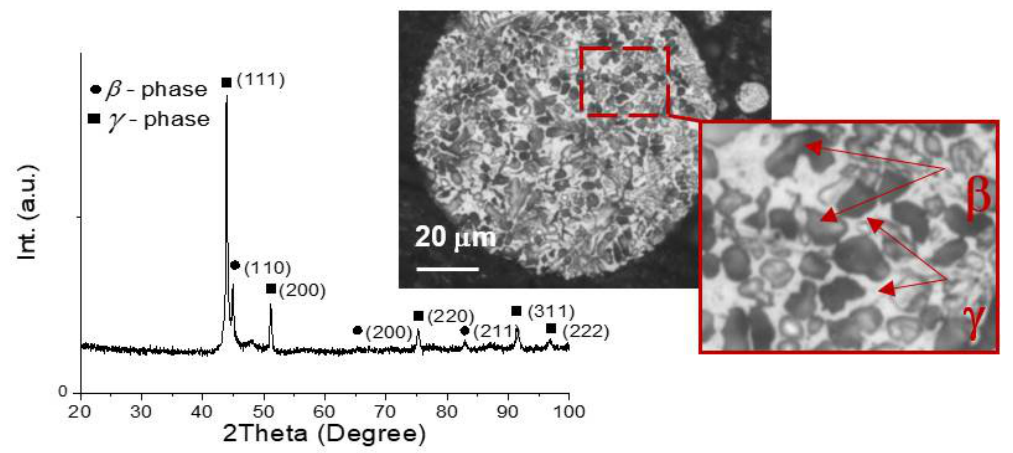
Figure 6. X-ray diffraction pattern and micrograph of Ni 36 Al 27 Co 37 powder after plasma spheroidization.